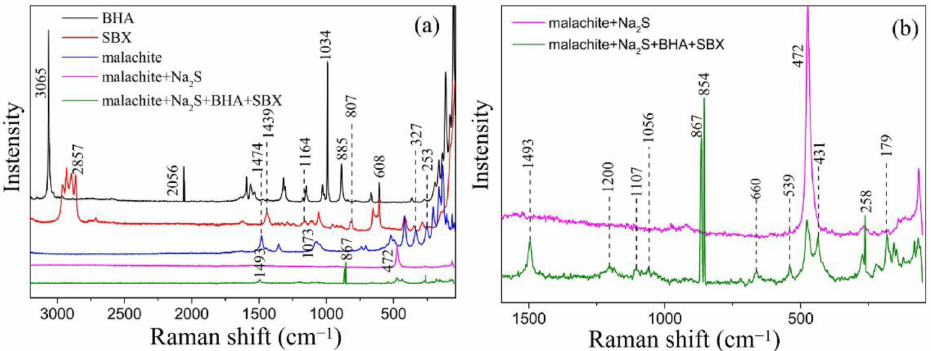
Figure 7. Raman spectra of BHA, SBX, and malachite before and after the treatment with Na 2 S and mixed collectors. ( a ) The range of Raman spectra is from 40 to 3250 cm − 1 . ( b ) The range of raman spectra is from 40 to 1600 cm − 1